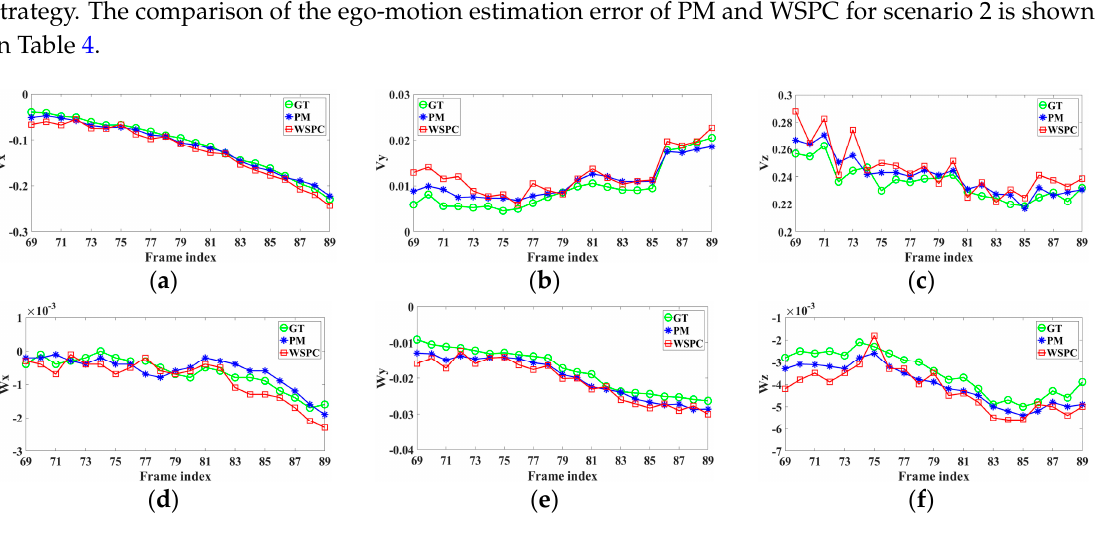
Figure 6. The feature points tracking results in scenario 2. ( a ) Frame 69; ( b ) Frame 70; ( c ) Frame 79; ( d ) Frame 89.